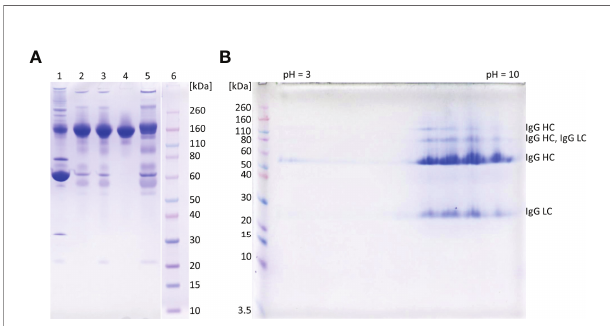
FIGURE 3 | SDS-PAGE analysis of representative samples from puri fi cation process. 1D gel electrophoresis (A) . Lane 1, COVID-19 convalescent plasma; lane 2, IgG fraction obtained by caprylic acid precipitation; lane 3, IgG fraction after dia fi ltration; lane 4, fl ow-through fraction from anion- exchange chromatography ( fi nal product); lane 5, elution fraction from anion-exchange chromatography; lane 6, molecular weight standards. The analysis was done on 4-12% Bis-Tris gel under non-reducing conditions. Staining was performed with CBB R250. 2D gel electrophoresis of the fi nal product (B) . In the fi rst dimension IgG ( m = 250 m g) was focused using IPG strip under denaturing conditions (linear pH 3-10). Prior second dimension IPG strip was reduced, alkylated and loaded to a 4-12% gel. Proteins were detected with CBB R250 and identi fi ed by MS/MS analysis (LC, light chain; HC, heavy chain). Molecular mass markers are at left side.